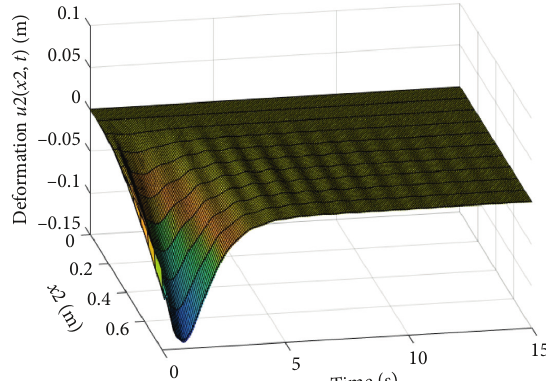
Figure 6: Deformation of the second link.